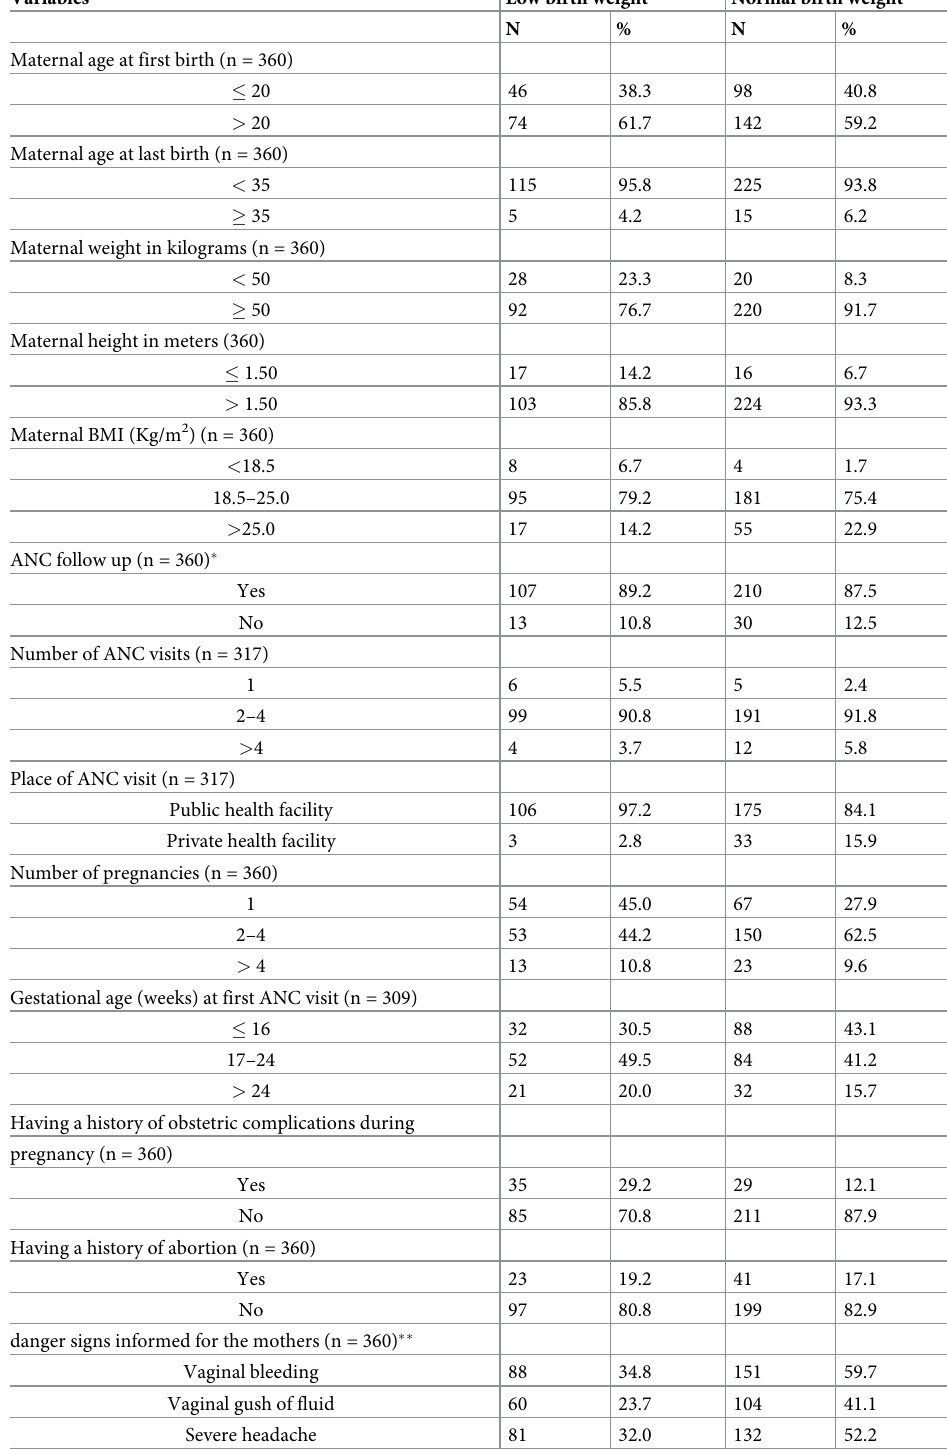
Table 2. Maternal/Obstetric characteristics of respondents in North Wello zone Hospitals, Ethiopia, December